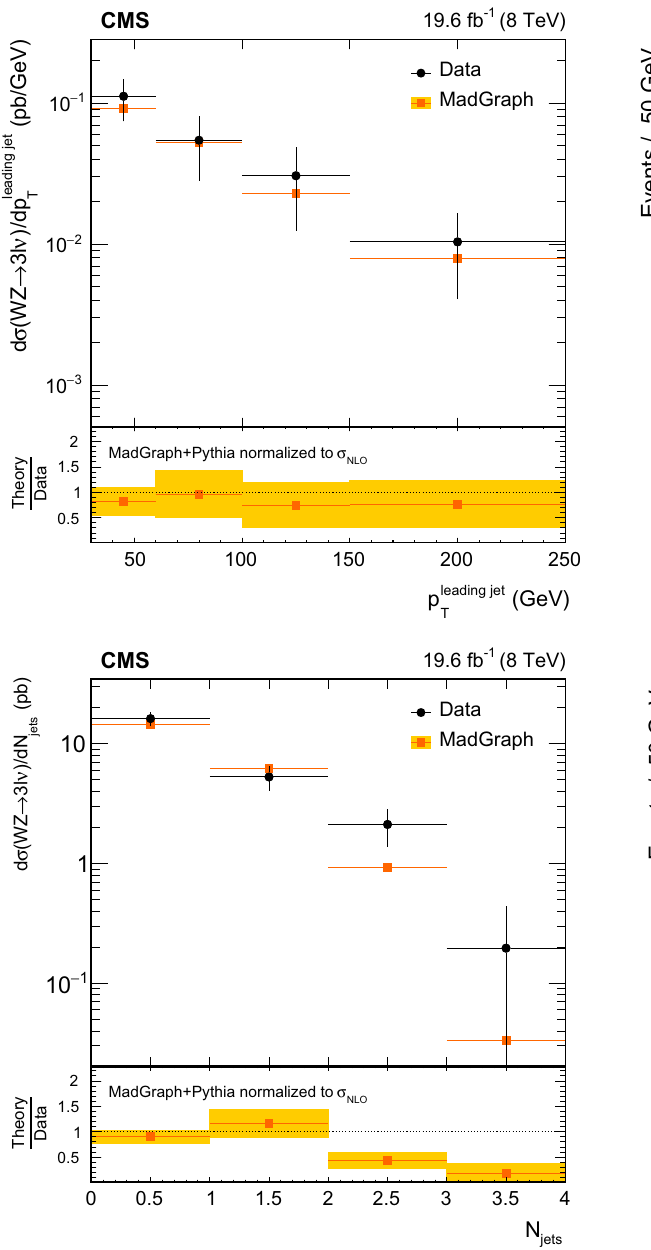
Fig. 7 TransversemomentumdistributionoftheZbosoncandidates,in linear scale ( top ) and log scale ( bottom ) for all channels combined. The SM WZ contribution ( light orange ) is normalized to the predicted cross section from mcfm . Dashed lines correspond to aTGC expectations with different parameter values. The last bin includes the integral of the tail 3 g 2 m 2 W λ = λ γ = c . Z WWW 2 (cid:18) 2 The presence of anomalous triple gauge couplings would be manifested as an increased yield of events, with the largest increase at high Z boson transverse momentum ( p Z spectrum for some aTGC values is obtained expected p Z T